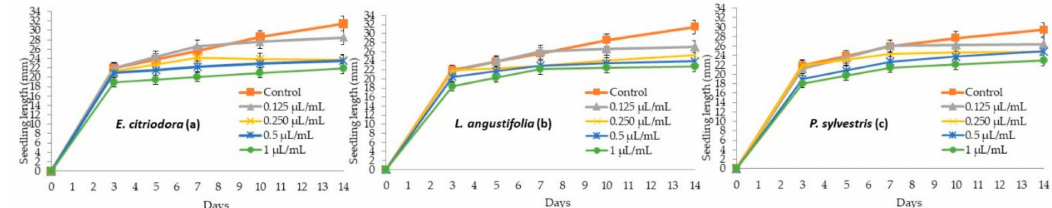
Figure 3. Phytotoxic e ff ect of E. citriodora ( a ), L. angustifolia ( b ), and P. sylvestris ( c ) essential oils at 0.125, 0.25, 0.5, and 1 µ L / mL on the seedling growth (hypocotyl + radicle) of